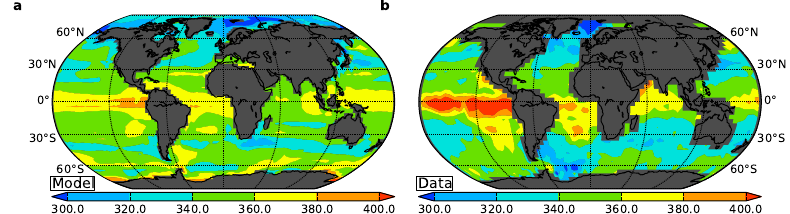
Figure 17. p CO 2 distribution at the ocean surface (µatm). Data from Takahashi et al. (2009).